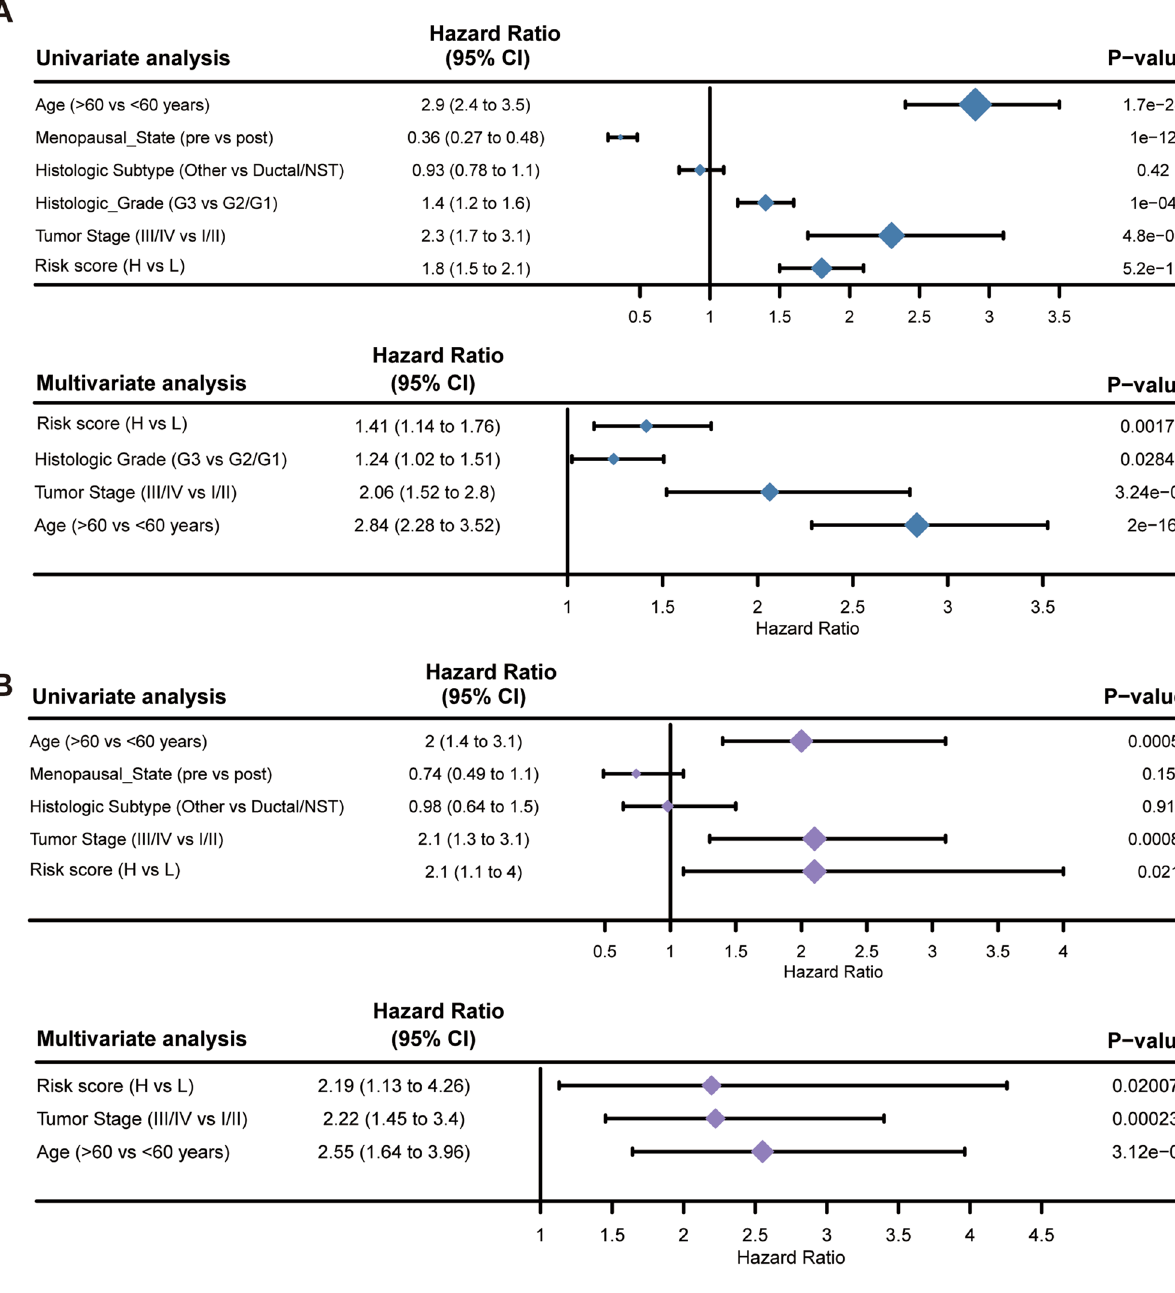
Figure 4. Results of the univariate and multivariate Cox regression analyses of OS in the METABRIC derivation cohort ( A ) and the TCGA validation cohort ( B